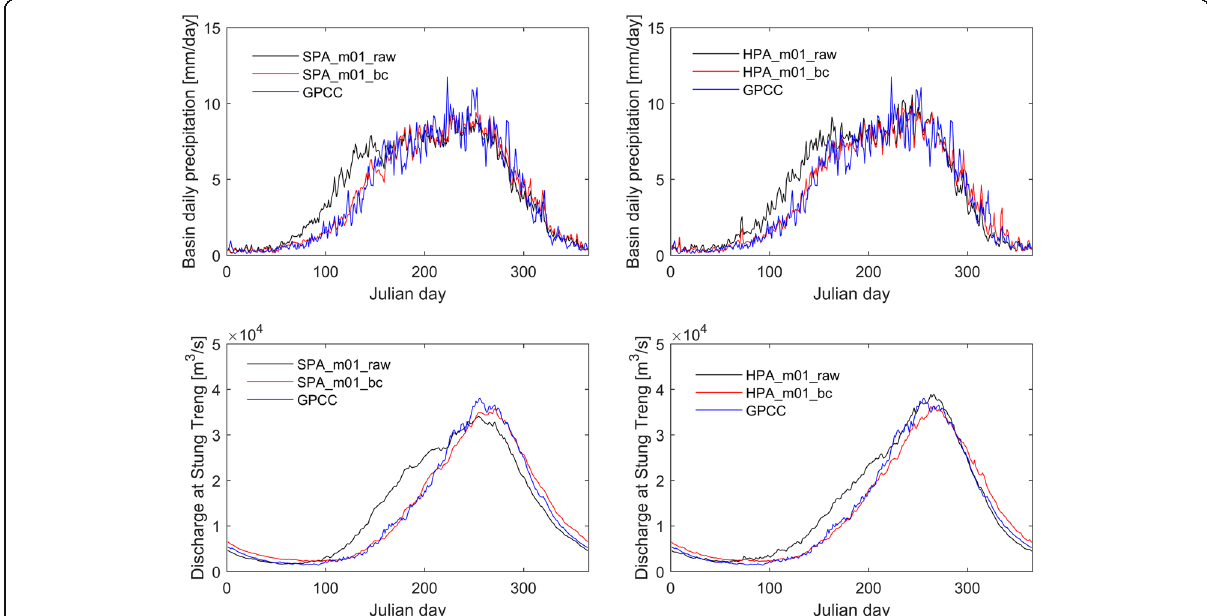
Fig. 4 Comparison of raw and bias corrected average daily precipitation and discharge at Stung Treng for historical AGCMs (SPA_m01 and HPA_m01) with GPCC